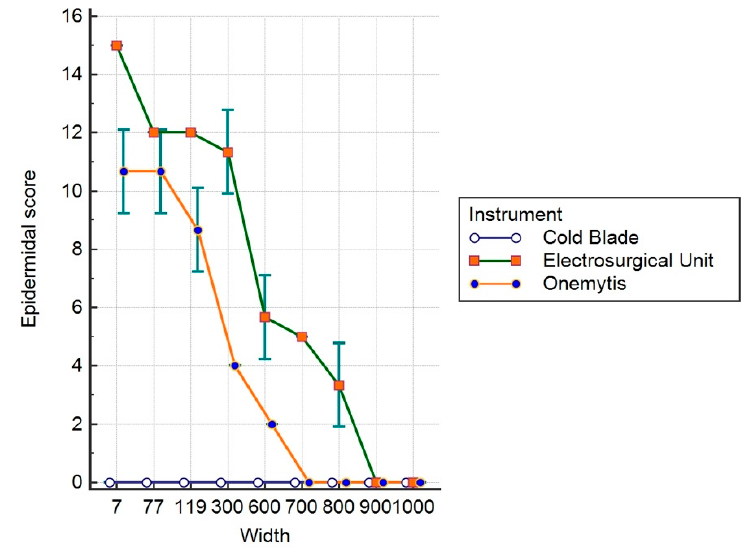
Figure 4. Epidermal score.